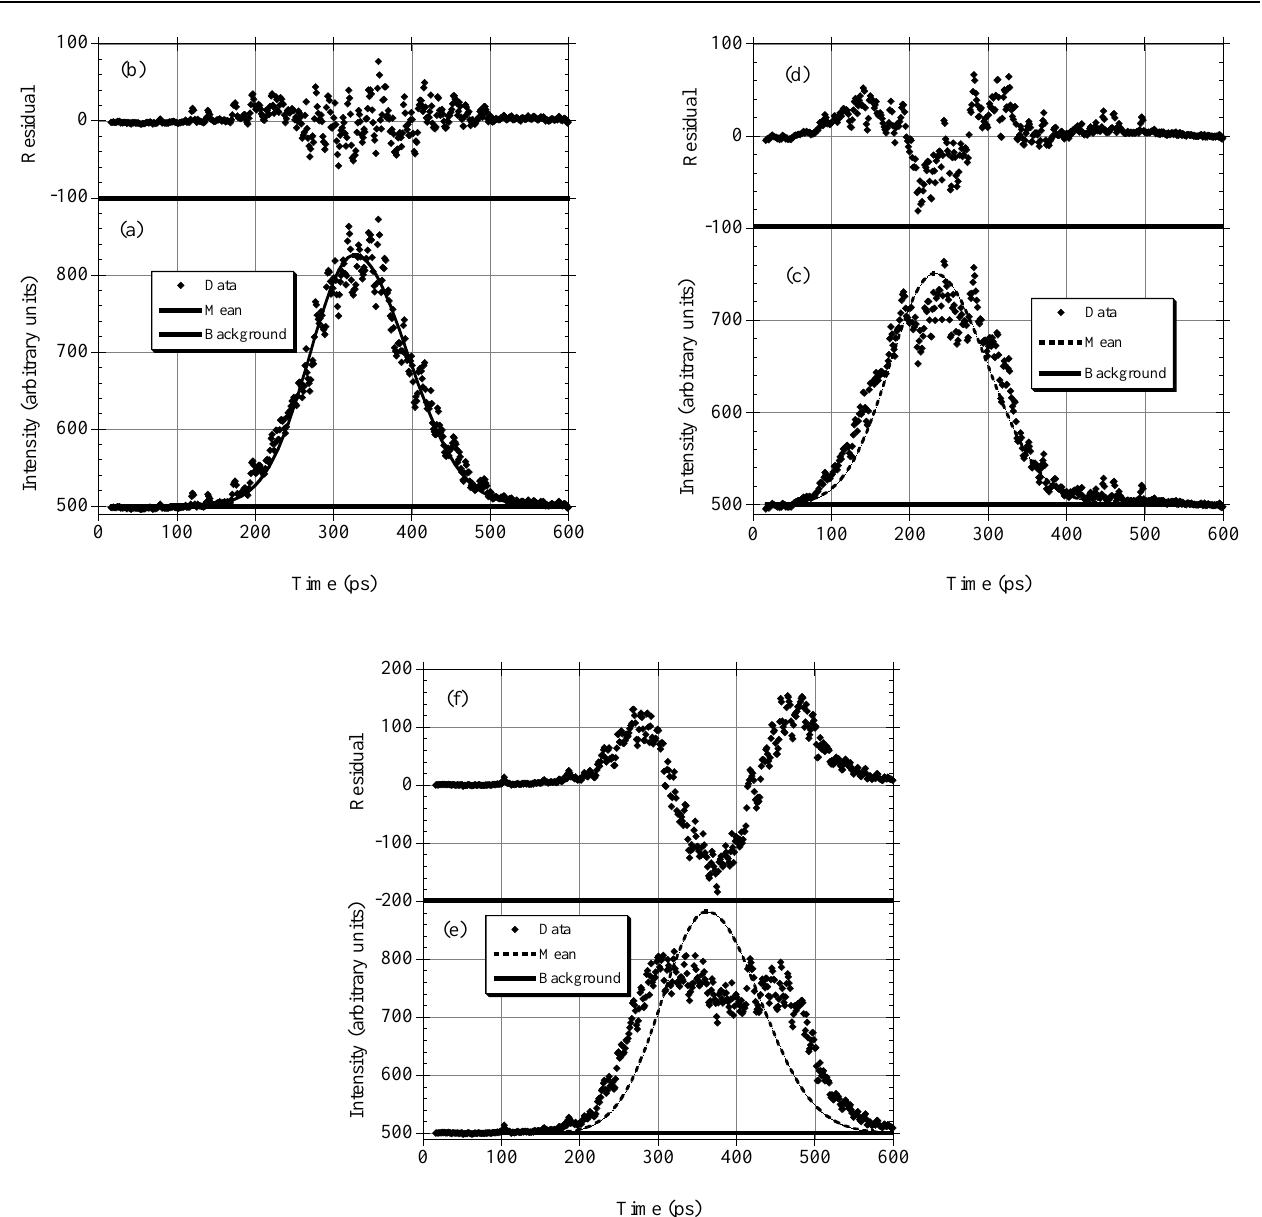
FIG. 16. A single data acquisition of the longitudinal bunch distribution when the amplitude of the rf voltage is modulated at a frequency of 349.9 kHz and signal generator voltage amplitude of (a) 0 dBm, (c) 1 5 dBm, and (e) 1 10 dBm. The residuals from the mean stable distribution are for the above signal voltages of (b) 0 dBm, (d) 1 5 dBm, and (f) 1 10